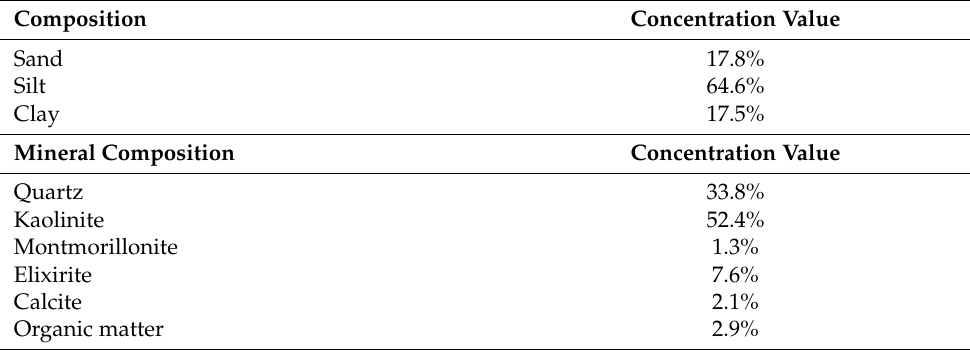
Table 2. Concentration of composition in sample soil.